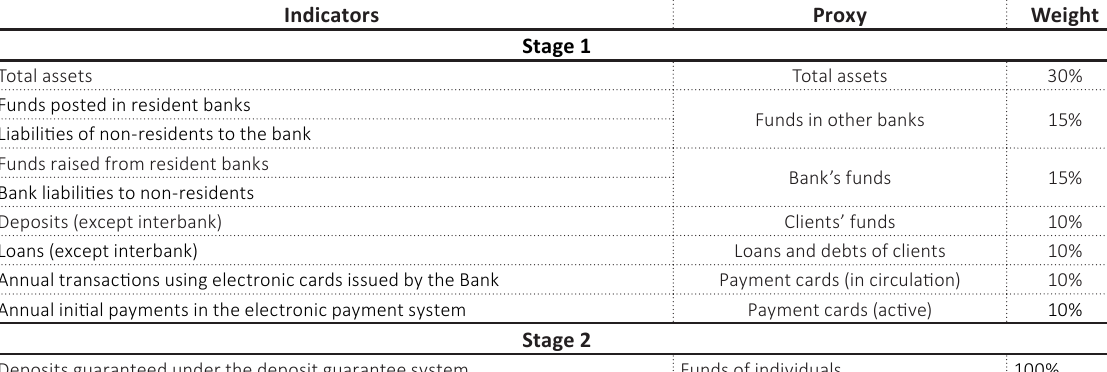
Sources: Compiled by authors